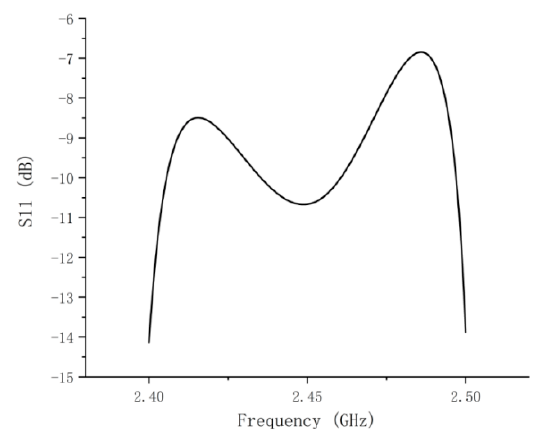
Figure 7. S11 of optimized model.